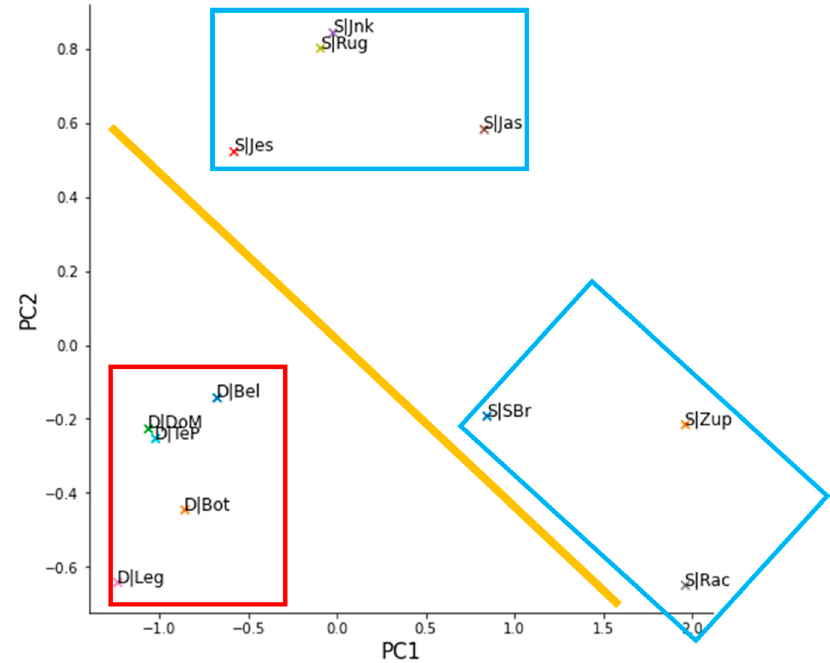
Figure 4. Summed PhACs/IDrgs mass flow over across the sites transformed by principal component analysis (PCA). The plot is showing PCA scores of the sites in the Sava River: Jankomir–S|Jnk,